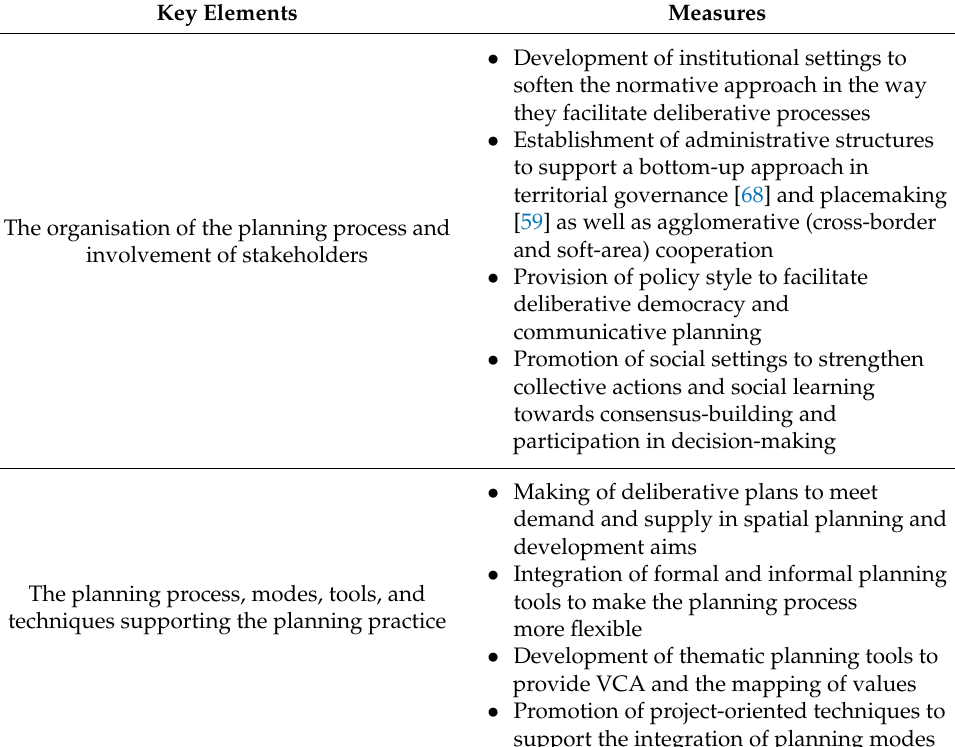
Table 3. The framework for the implementation of the VLP